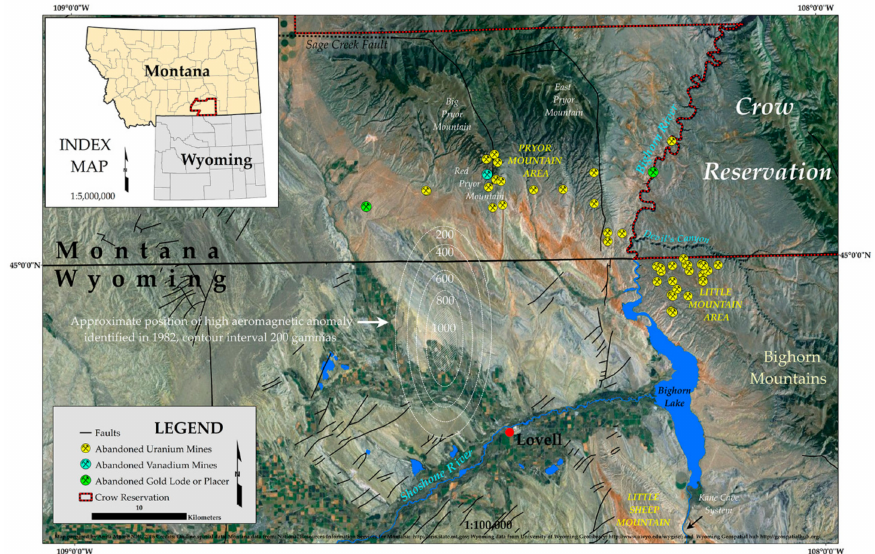
Figure 1. Map showing the location of the Pryor Mountain and the Little Mountain areas in southcentral Montana (MT) and northcentral Wyoming (WY). The yellow symbols represent abandoned U-V mines. The southern portion of the Crow Reservation, outlined by the red and black line, borders the Little Mountain U-V Mining District (LMD). The Bighorn River is superimposed across Little Sheep Mountain, WY, shown at the bottom of the map. The river flows north through WY between the two mining districts and then northeast through MT, there forming the southwest border of the Crow Indian Reservation. Approximate location of high aeromagnetic anomaly identified in 1982 described in text is shown with dashed lines to southwest of Red Pryor